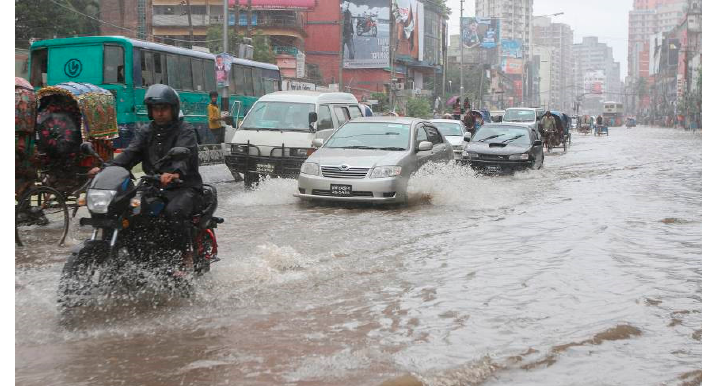
Figure 2. Flooding in Dhaka resulting from rainfall (Photo captured by Nashirul Islam/ Dhaka Tribune).